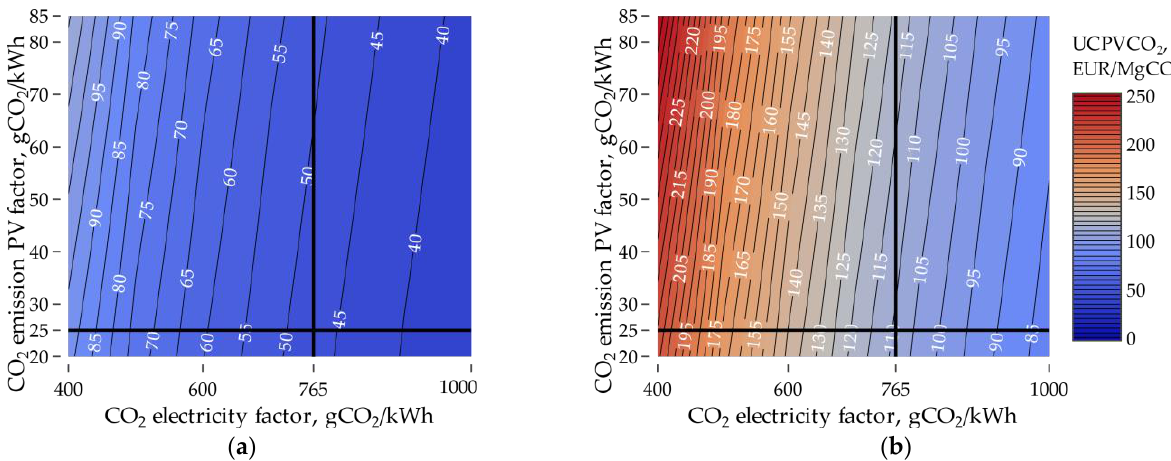
Figure 19. Unit (investment) cost of CO 2 emission reduction as a function of CO 2 emission factor in the national grid and emissions related to the production of panels: ( a ) Leki; ( b ) Bydgoszcz.